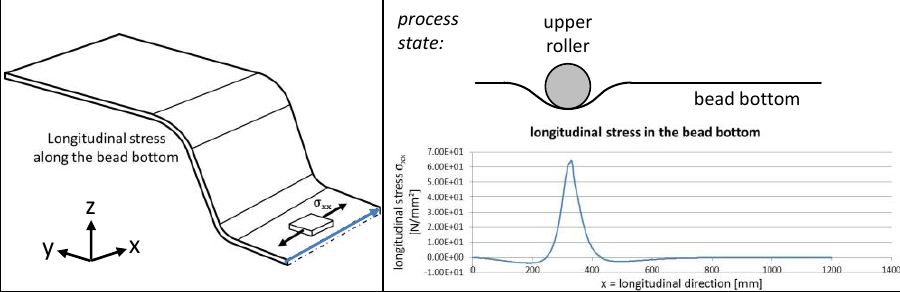
Figure 14. Longitudinal stresses along the profile bottom during the process.